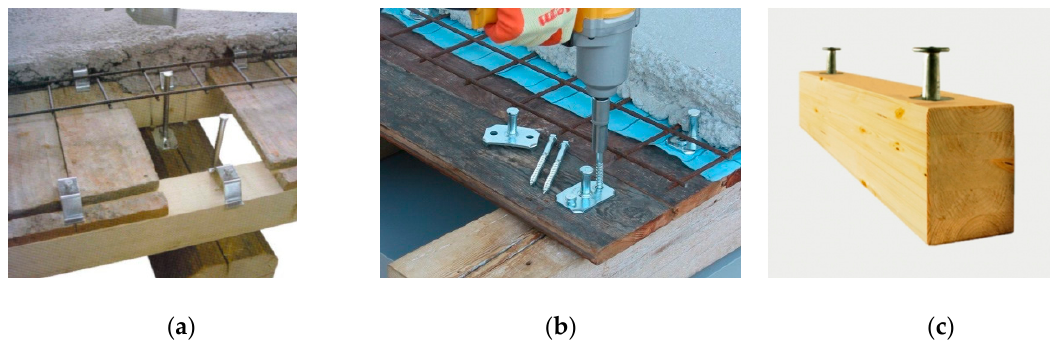
Figure 29. Examples of metal and shear stainless steel studs [82,83].